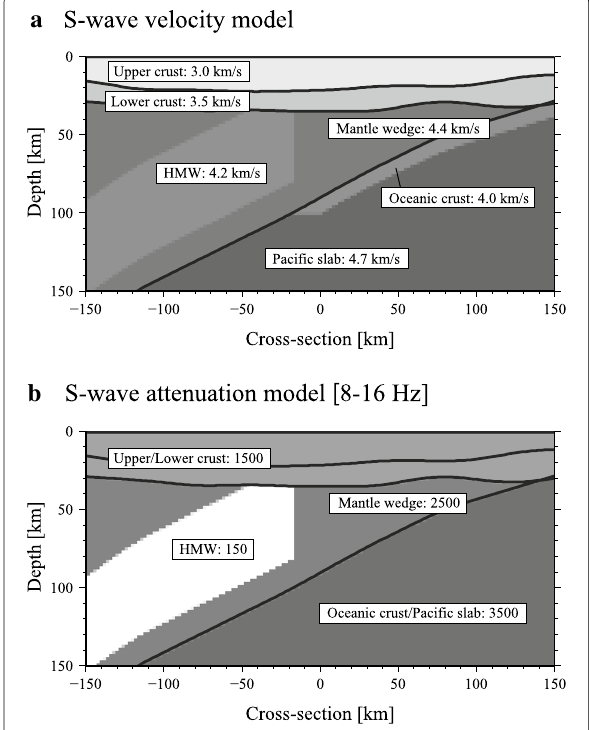
Fig. 4 a S-wave velocity and b attenuation models including the high-attenuation zone in the mantle wedge (HMW) along cross-section D (Fig. 1). b Values in white boxes are the Q S values at 8–16 Hz. The three black lines represent the structural boundaries of the Conrad and Moho discontinuities (Katusmata 2010), and the upper boundary of the Pacific slab (Nakajima et al.